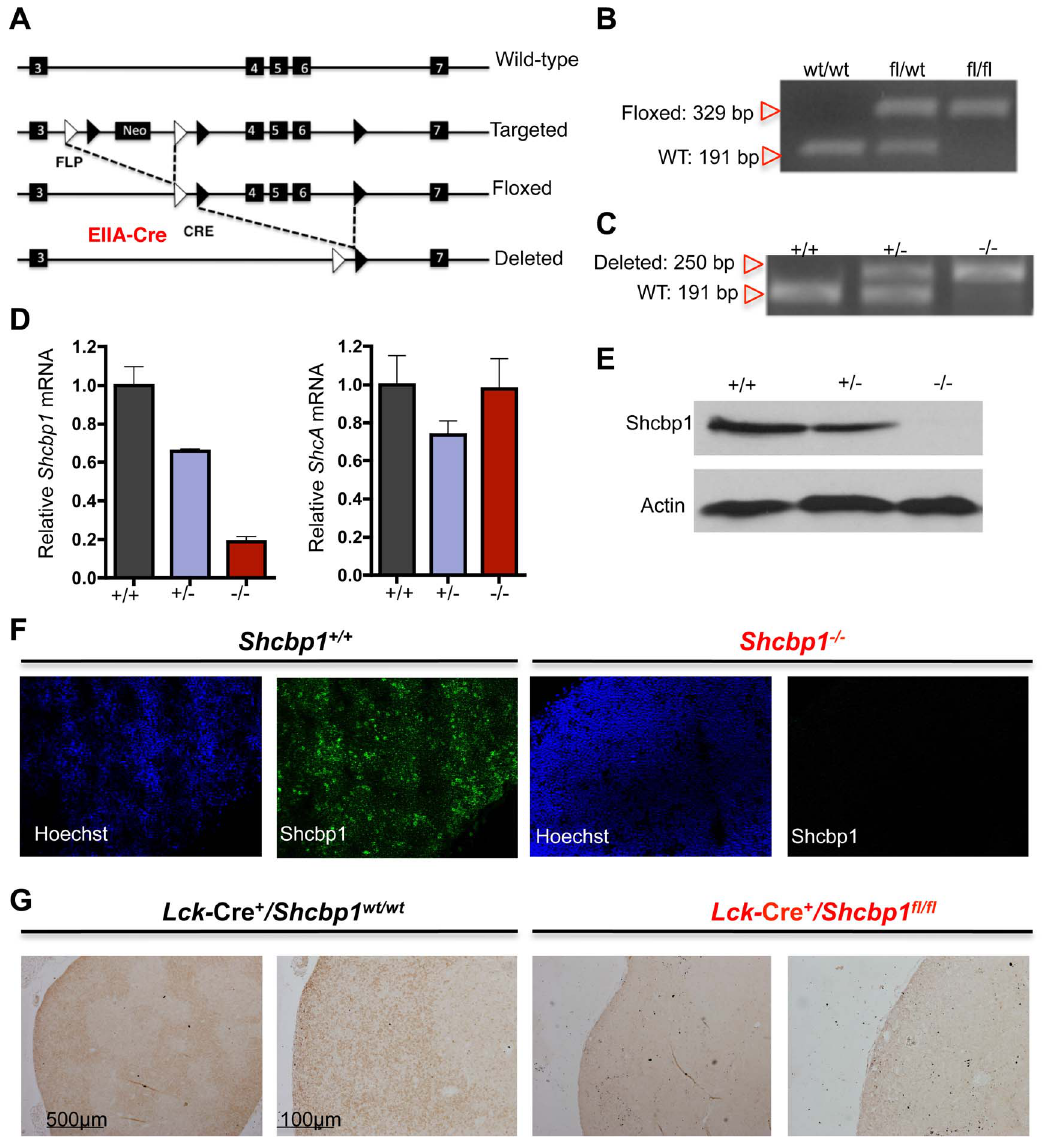
Figure 3. Generation of mice with conditional and global deletion of Shcbp1 . (A) Schematic detailing the generation of mice carrying global deletion of Shcbp1 and the strategy for conditional deletion of Shcbp1 exons 4–6 and the neomycin targeting cassette. (B) Identification of mice with a floxed or WT Shcbp1 loci ( Shcbp1 wt/wt , Shcbp1 fl/wt , and Shcbp1 fl/fl ) assessed by genotyping PCR in tail DNA. (C) Genotyping PCR for Shcbp1 WT and Shcbp1 deleted loci in tail DNA from mice with the indicated genotypes. (D) Left, Shcbp1 mRNA levels in thymocytes isolated from Shcbp1 + / + , Shcbp1 + / 2 , and Shcbp1 2 / 2 mice normalized to HPRT and to control Shcbp1 + / + mice (n=2–5 mice per genotype). Right, ShcA mRNA levels in thymocytes isolated from mice of the indicated genotype normalized to HPRT and to control Shcbp1 + / + mice (n=2–5 mice per genotype). (E) Immunoblotting of Shcbp1 in total thymocytes from mice with the indicated genotypes (representative of n=3 experiments). (F) Immunofluorescence of thymi from wild-type and Shcbp1 2 / 2 mice with staining for Hoechst and Shcbp1 (representative of n=2 experiments). (G)Immunohistochemistry of Shcbp1 in thymic tissue from wild type and Shcbp1 -deficient mice (representative of n=3 experiments).